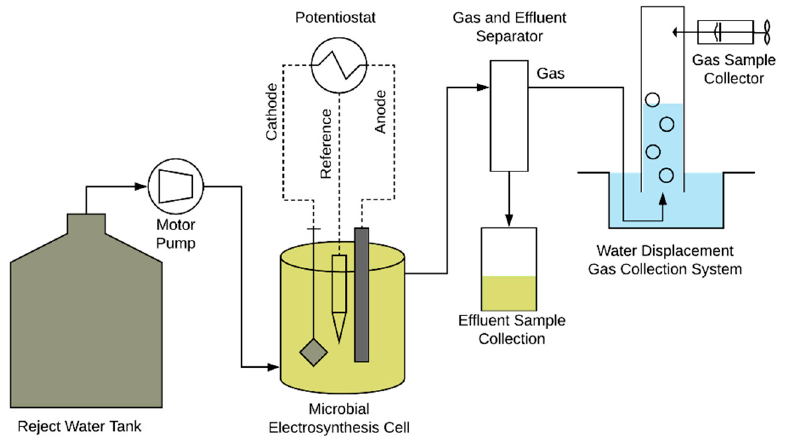
Figure 1. Biomethane production experimental setup for both optimisation and control experiments.